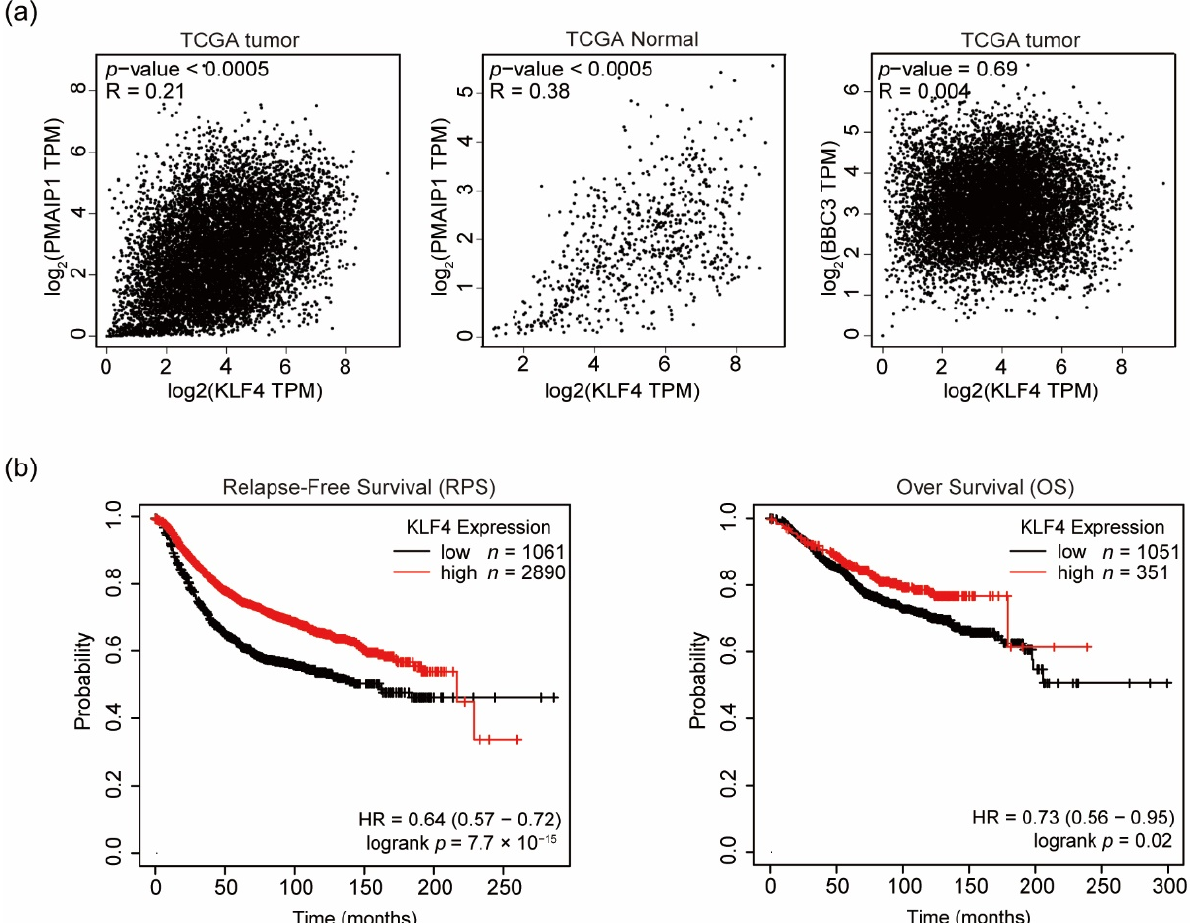
Figure 5. Correlation between KLF4 and NOXA expression in breast cancer tissues and the effect of KLF4 expression in breast cancer patients. ( a ) The correlation between KLF4 expression and NOXA (gene name PMAIP1; left and middle) and PUMA (gene name BBC3; right) expression based on the Cancer Genome Atlas (TCGA) dataset are illustrated. ( b ) Kaplan– Meier curves of relapse-free survival (RFS; left panel) and overall survival (OS; right panel) in breast cancer patients were plotted according to the KLF4 expression levels (high vs. low). The p -value of the log-rank test, hazard ratio, and confidence interval are shown in each